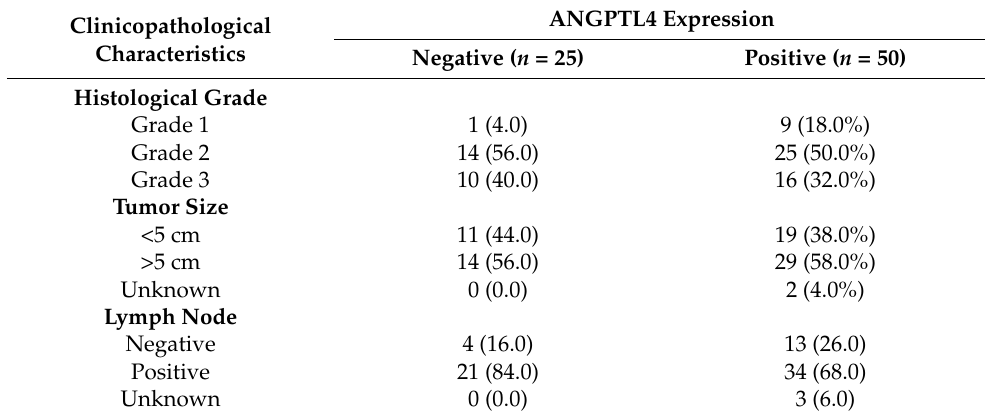
Table 6. Patients’ clinicopathological characteristics based on the ANGPTL4 status ( n =